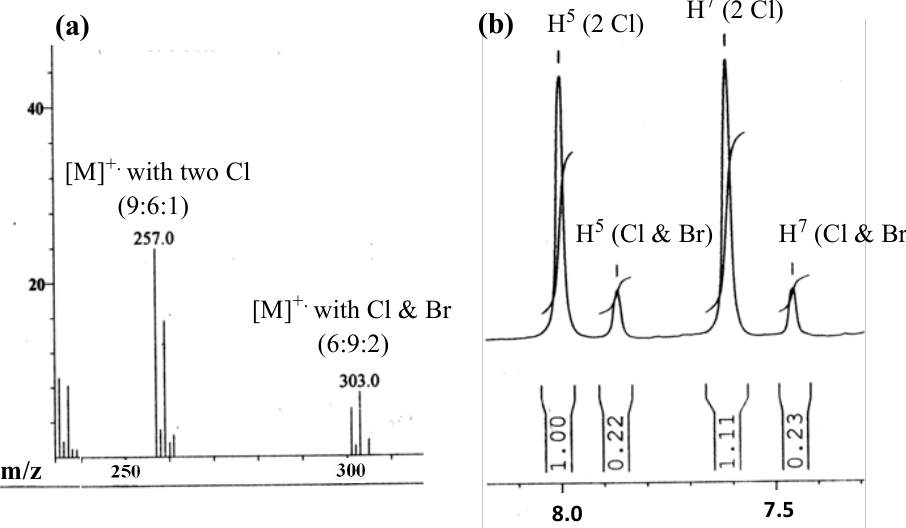
Figure 1. A part of ( a ) LR EIMS showing the predominance of 5a molecular ions; ( b ) the 1 H-NMR elaborating the level of predominance of Cl-substituted benzoxazinone 5a over Br-substituted benzoxazinone 5b